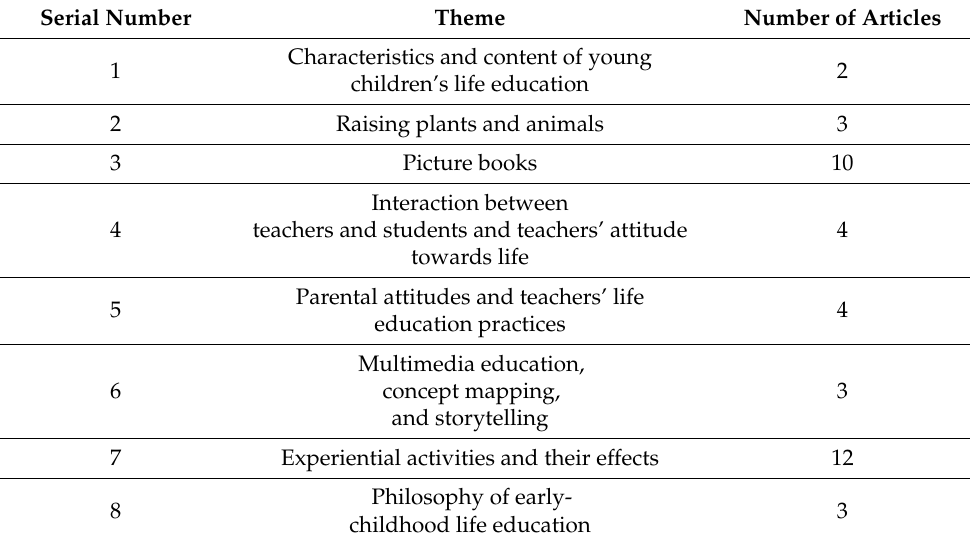
Table 1. Themes extracted from studies on life education for young